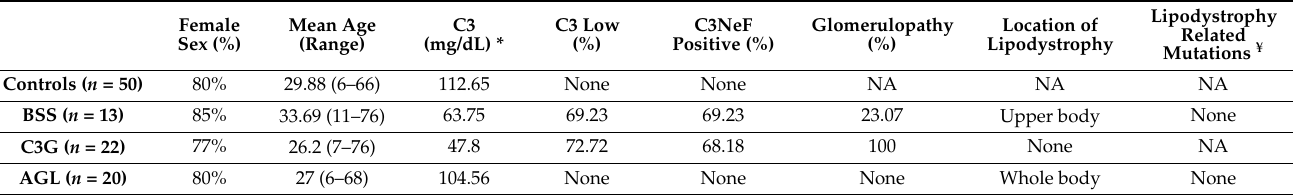
Figure 1. Plasma FD levels. ( A ) FD levels were quantified in plasma samples from controls ( n = 50), patients with Barraquer–Simons syndrome (BSS, n = 13), patients with C3 glomerulopathy (C3G, n = 22), and patients with acquired generalized lipodystrophy (AGL, n = 20). The results are presented as medians and interquartile ranges. Differences between groups were assessed by the Kruskall– Wallis test. p < 0.05 was considered statistically significant. ( B ) FD levels were assessed by Western blot, confirming that FD was elevated in patients with BSS and decreased in patients with AGL. Table 1. Clinical and demographical data of all